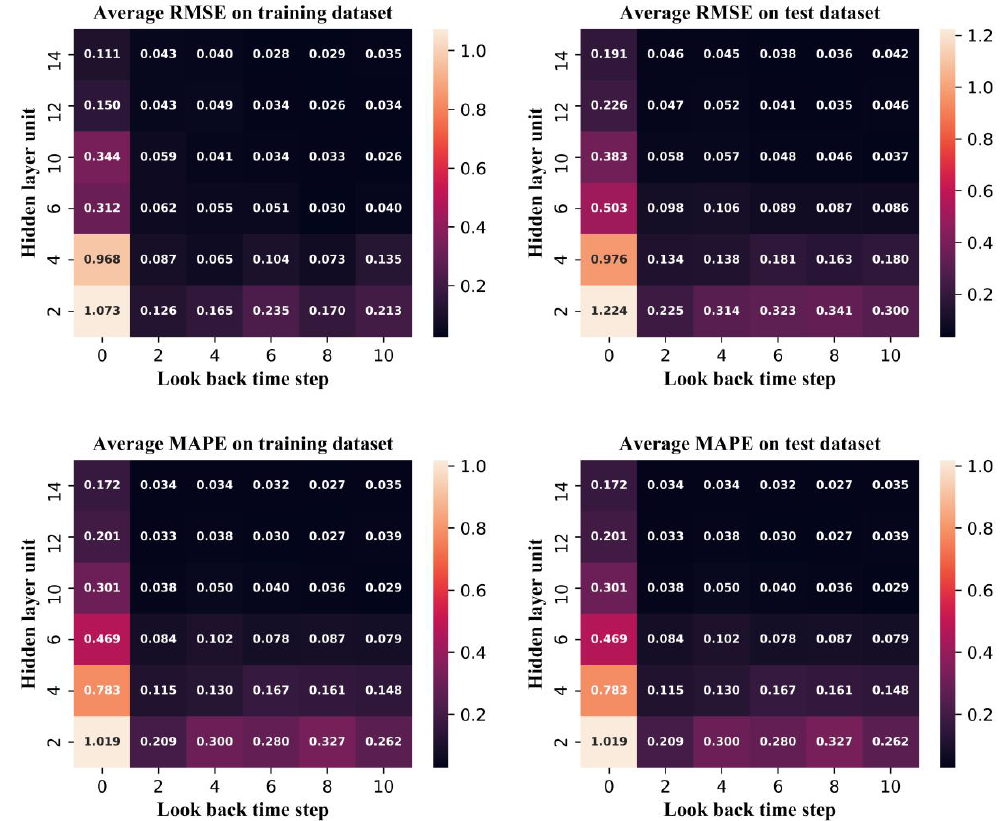
ff erence combination.